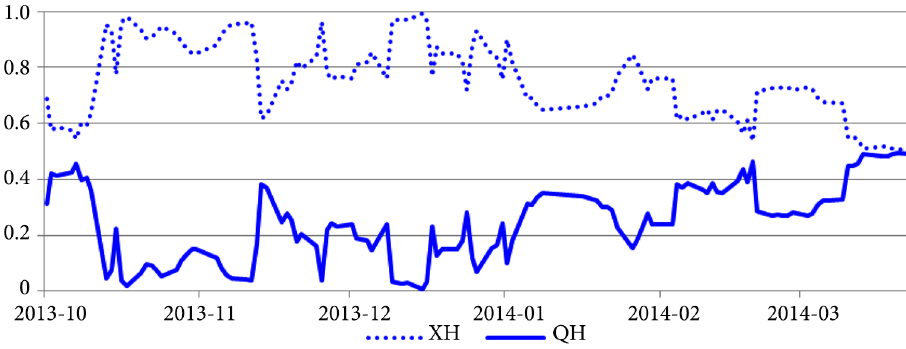
Figure 3. Contribution of price discovery in iron ore futures market (QH) and spot market (XH) (time: